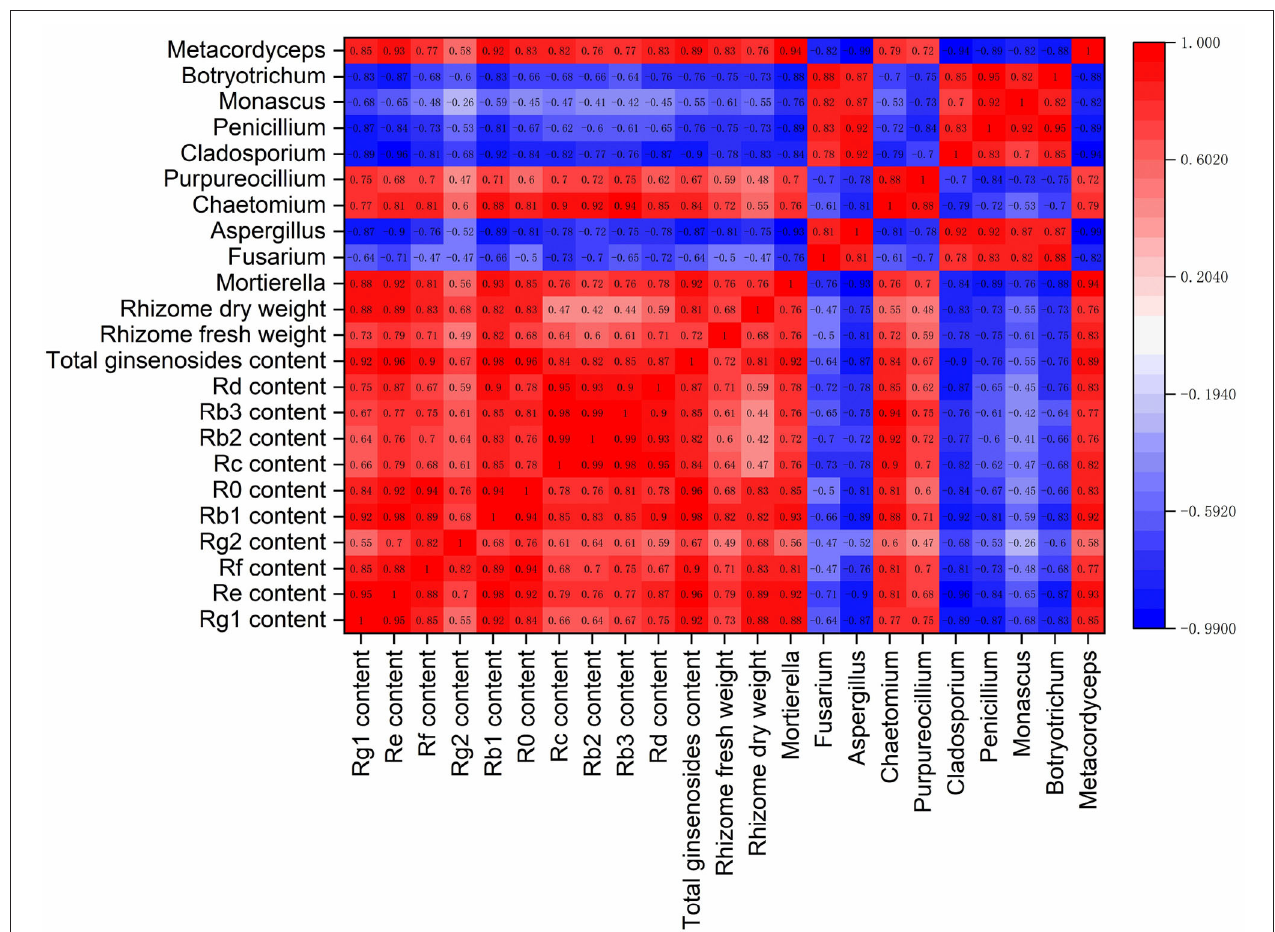
FIGURE 8 | Correlation matrix of ginseng yield, ginsenoside contents, and dominant genera of rhizosphere fungi ( n =